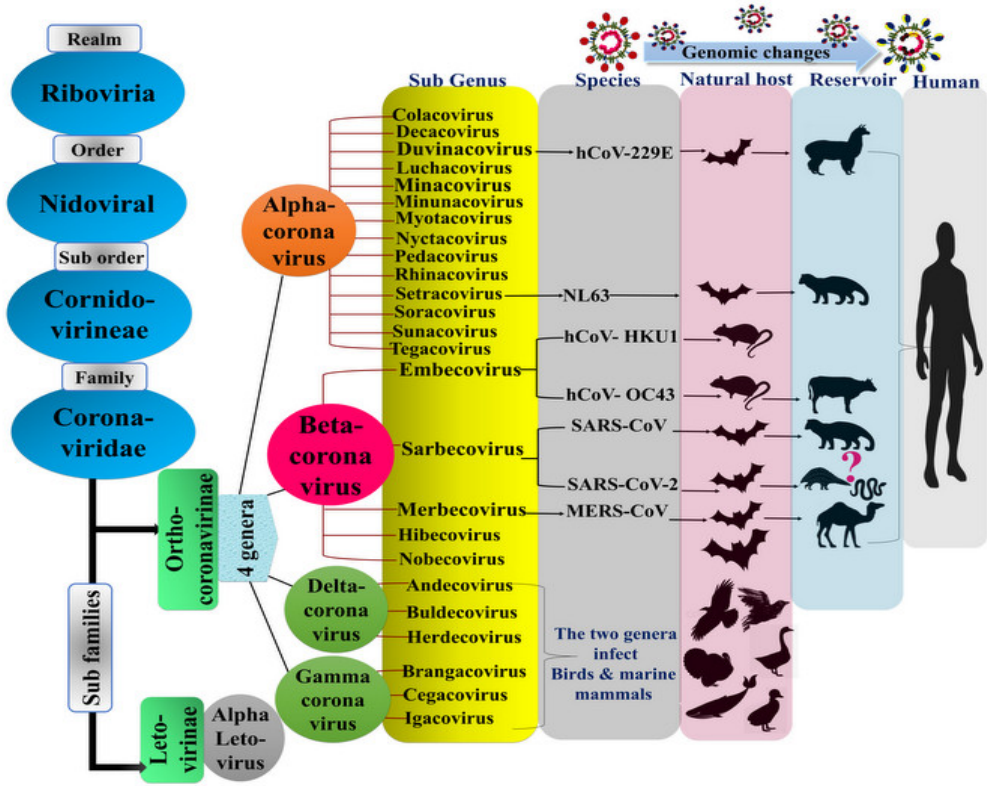
Figure 1. Coronavirus taxonomy according to the International Committee on Taxonomy of Viruses (ICTV) showing the classification of the SARS‐CoV‐2. Genomic changes of the virus enabled reemergence and jumping from the original host (bats) to the intermediate host, and finally to humans, in a tortuous evolutive pattern.